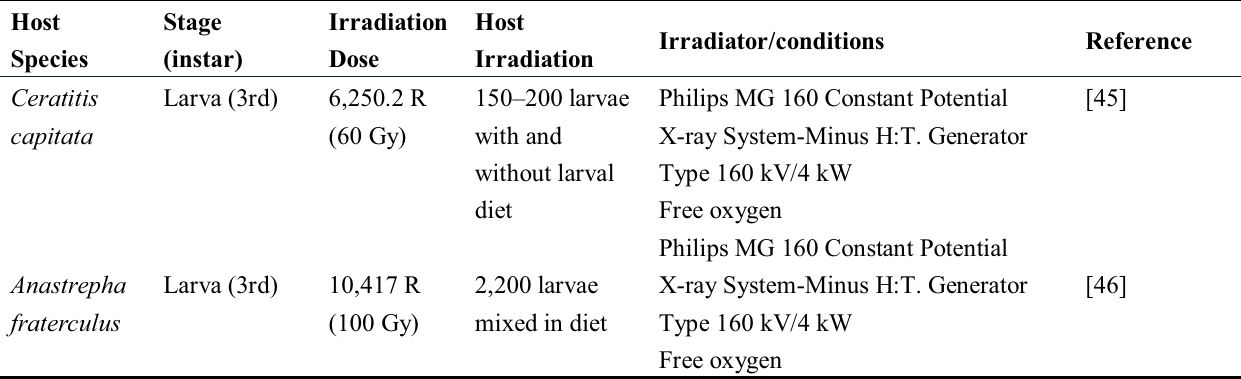
Table 2. X-ray doses applied in two fruit fly species for mass rearing the hymenopteran larval parasitoid D. longicaudata